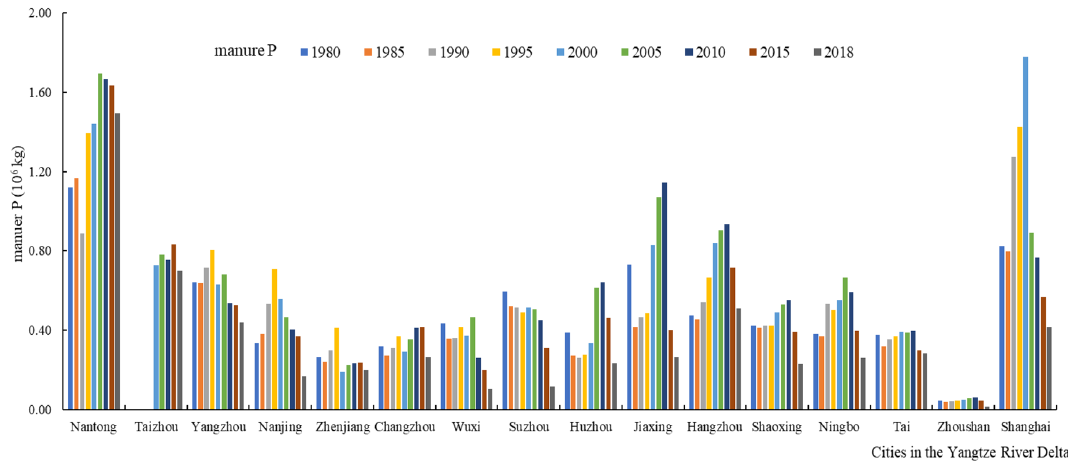
Figure 3. Manure P emissions in cities in the Yangtze River